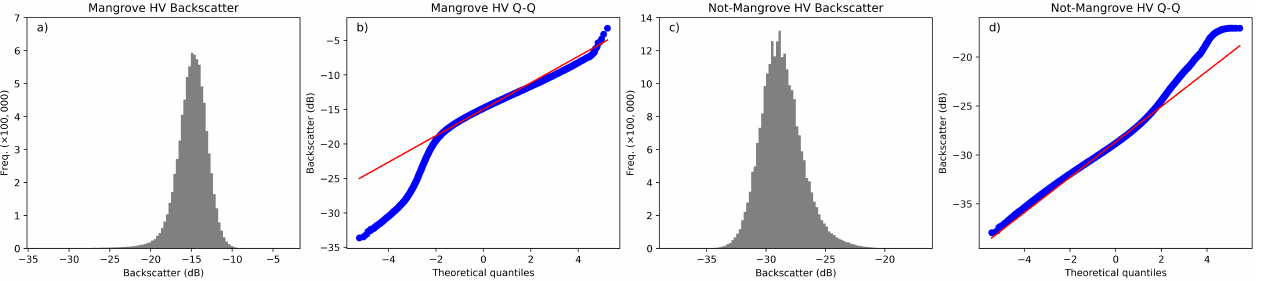
Figure 5. Illustrating the histograms of 2010 HV ALOS PALSAR backscatter from the 2010 mangrove baseline and non-mangrove contextual regions for project GMW-09-003, Sumatra, Indonesia. These histograms are representative of the other projects and both HH and HV polarisations. ( a ) The mangrove HV histogram and ( b ) Q-Q plot illustrating that the majority of the histogram is normal will a short tail in the lower values. ( c ) The non-mangrove HV histogram and ( d ) Q-Q plot illustrating that the majority of the histogram is normal with a small tail in the higher